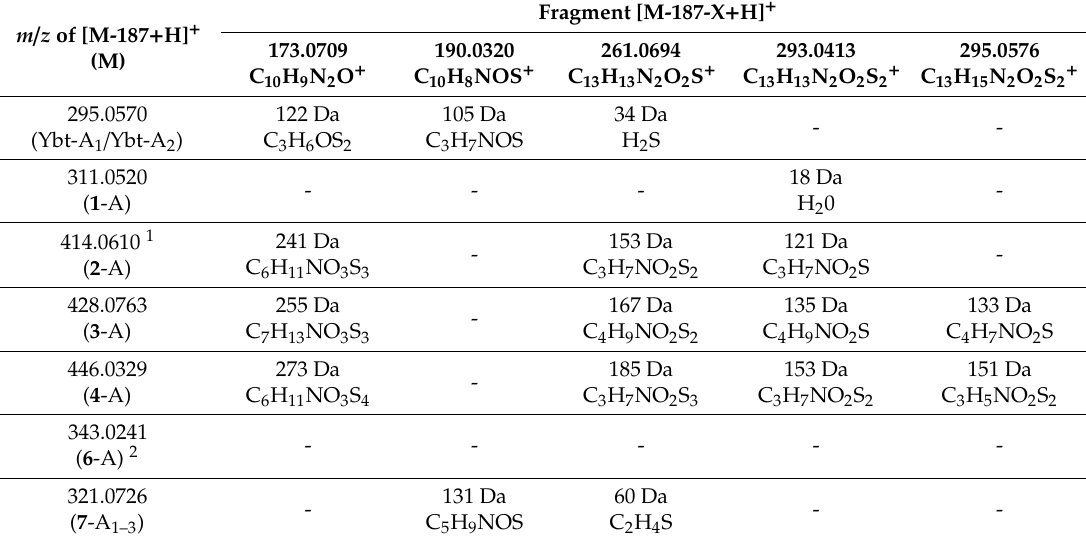
Table 6. Selected fragments resulting from di ff erent NLs recorded during MS 3 experiments of Ybt and its novel derivatives by application of LC-HRMS. All recorded fragmentation spectra are shown in the Supplementary Material. The specific NL [X] of a fragment leading to the ions [M-187-X + H] + listed on top of the columns is noted in the table. The most intense ion was used for MS 4 experiments. m / z of [M-187 + H] +